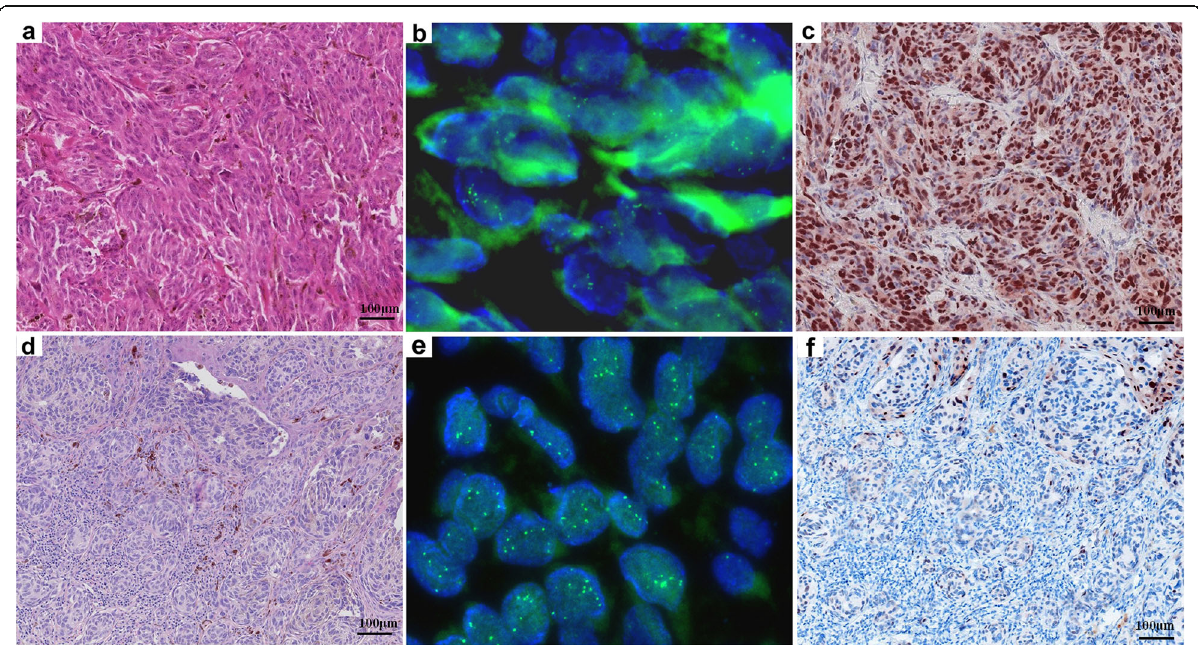
Fig. 4 Acral melanomas with high-level CCND1 copy number increase shows high cyclin D1 expression in most cases, but can also show low cyclin D1 expression in a small number of cases. An acral melanoma on the foot of a 49-year-old female with high-level CCND1 copy number increase shows high expression of cyclin D1 ( a , HE 100x; b , CCND1 copy number by FISH; c , cyclin D1 expression by IHC). An acral melanoma on the foot of a 47-year-old male with high-level CCND1 copy number increase shows low expression of cyclin D1 ( d , HE 100x; e , CCND1 copy number by FISH; f , cyclin D1 expression by IHC)